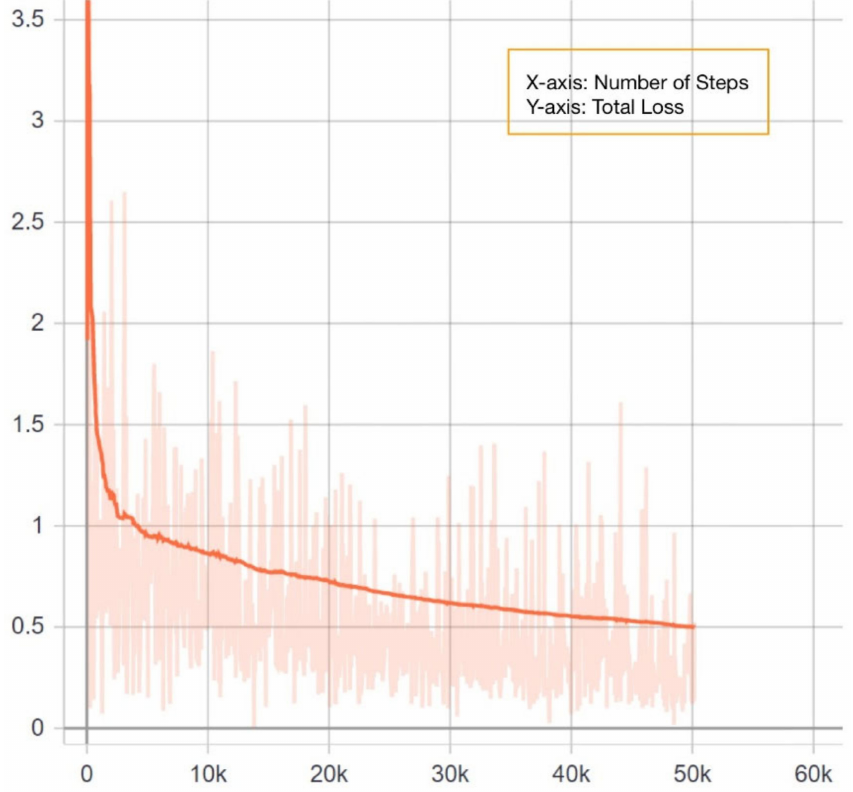
Figure 6. Faster-RCNN Loss